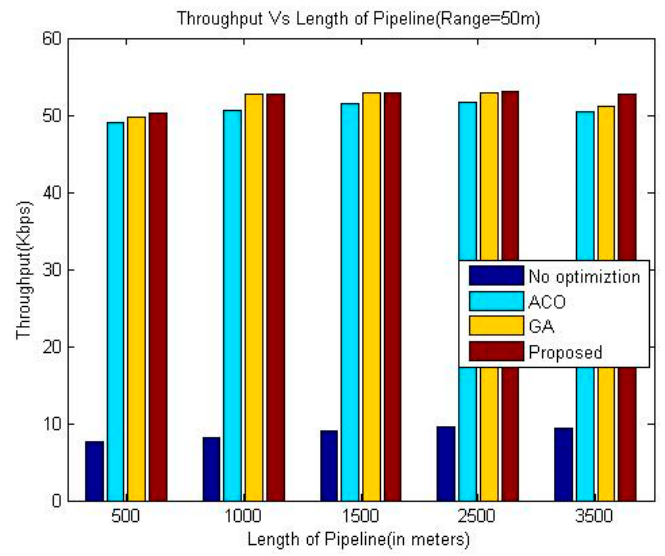
Figure 6. Comparison of Throughput (Range 25 m).